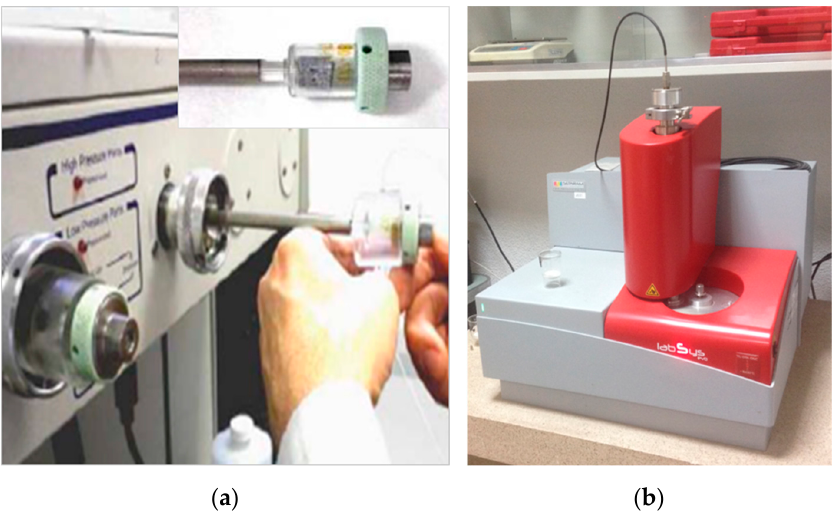
Figure 5. ( a ) Equipment used for MIP tests and penetrometer detail with cylindrical sample inside; ( b ) simultaneous thermal analyser used for DTA-TG tests. ( b ) simultaneous thermal analyser used for DTA-TG